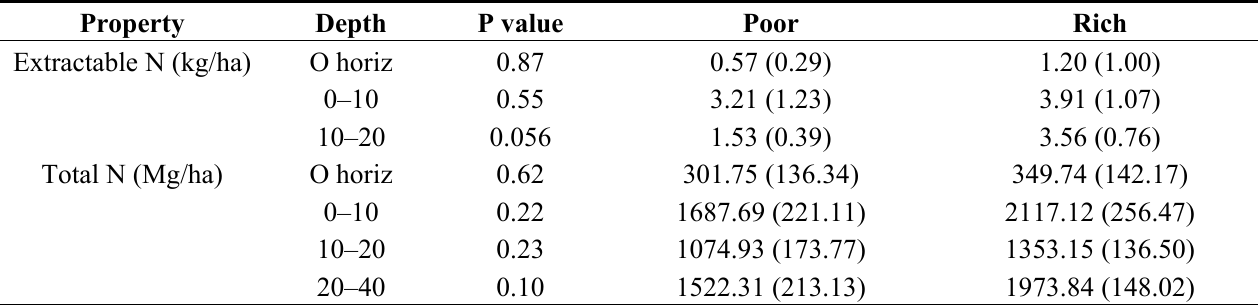
Table 7. Fertility class comparison averages (standard